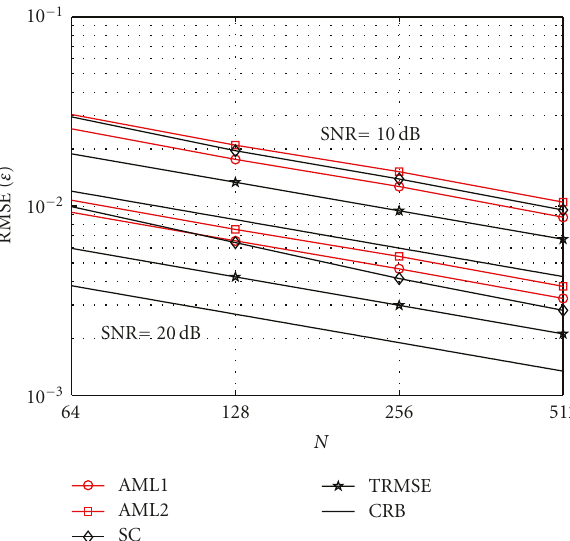
Figure 6: Performance of the considered CFO estimators as a function of the actual value of the normalized CFO.